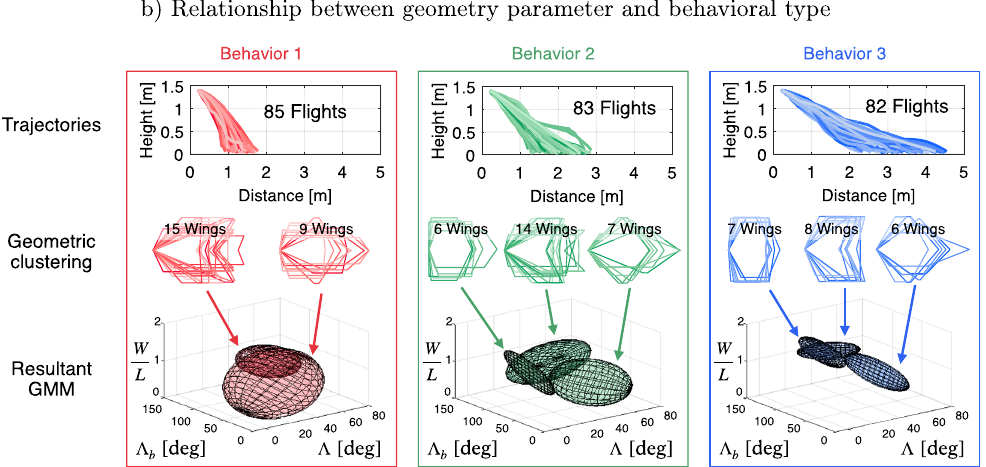
Figure 2. ( a ) Strength of relationship between geometry parameter and flight distance for 250 flights. ( b ) Relationship between geometry parameter and behavior type in geometry space G . ( c ) Flight trajectories, airplane geometries, and GMM representation for labeled behavioral